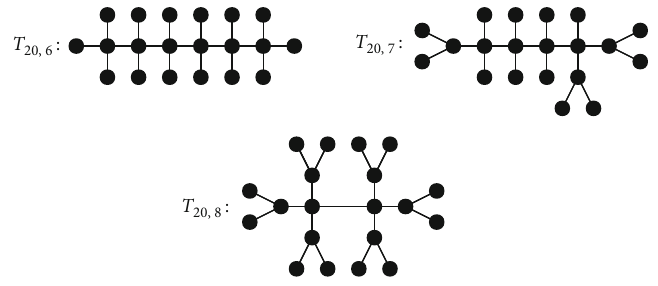
1 ≤ b < ð n − 2 Þ /3 . 20, b where